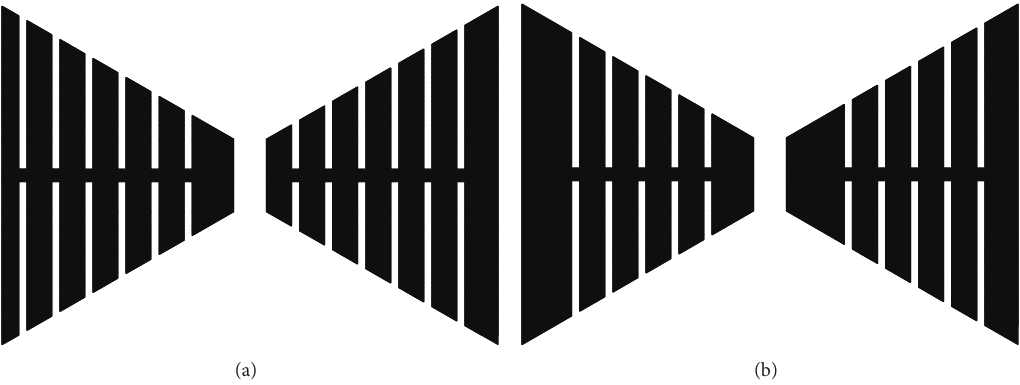
Figure 5: (a) The proposed bow-tie chipless RFID tag III with ID “111111111111”; (b) the proposed bow-tie chipless RFID tag IV with ID “011111111110.”